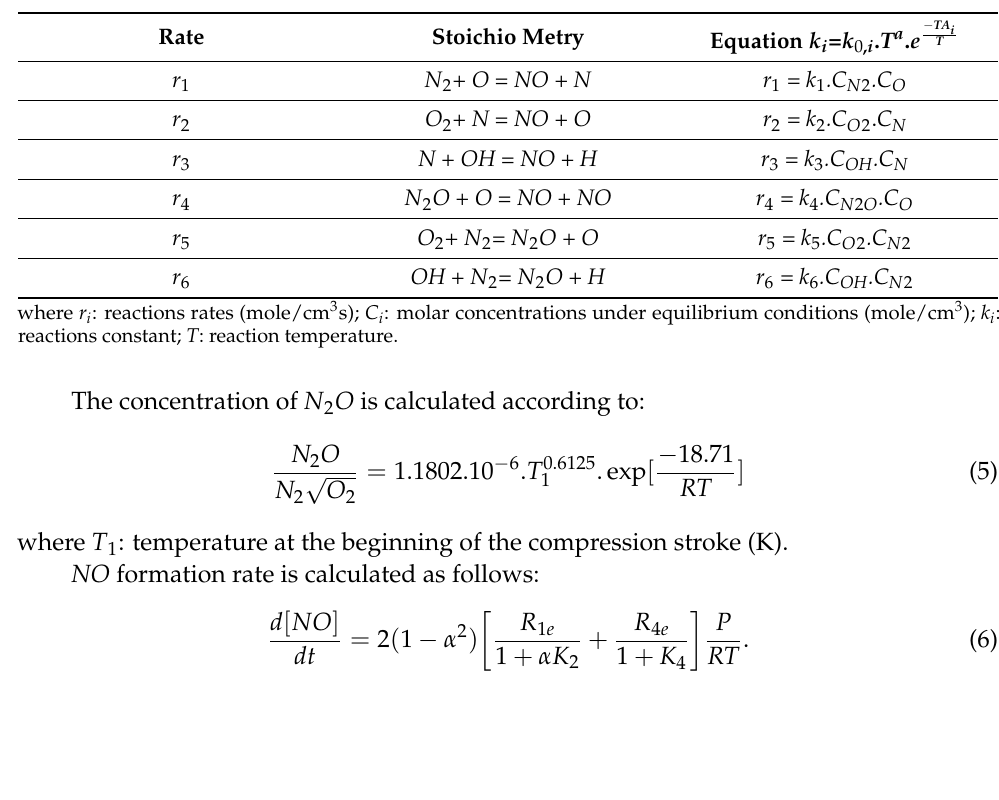
Table 1. NOx formation